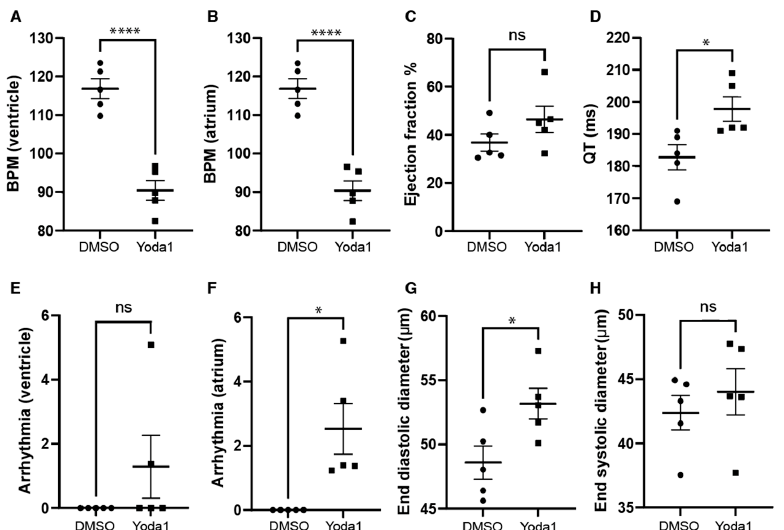
Figure 3. Cardiac physiology of Yoda1-treated larvae. ( A ) Ventricular rate. ( B ) Atrial rate. ( C ) Ejection fraction. ( D ) QT interval. ( E ) Ventricular arrhythmia. ( F ) Atrial arrhythmia ( G ) End diastolic diameter. ( H ) Ventricle maximum fractional length. n = 5. Statistical signi fi cance was assessed by independent t -test and Bonferroni correction. *: p -value < 0.05, ****: p -value < 0.0001.